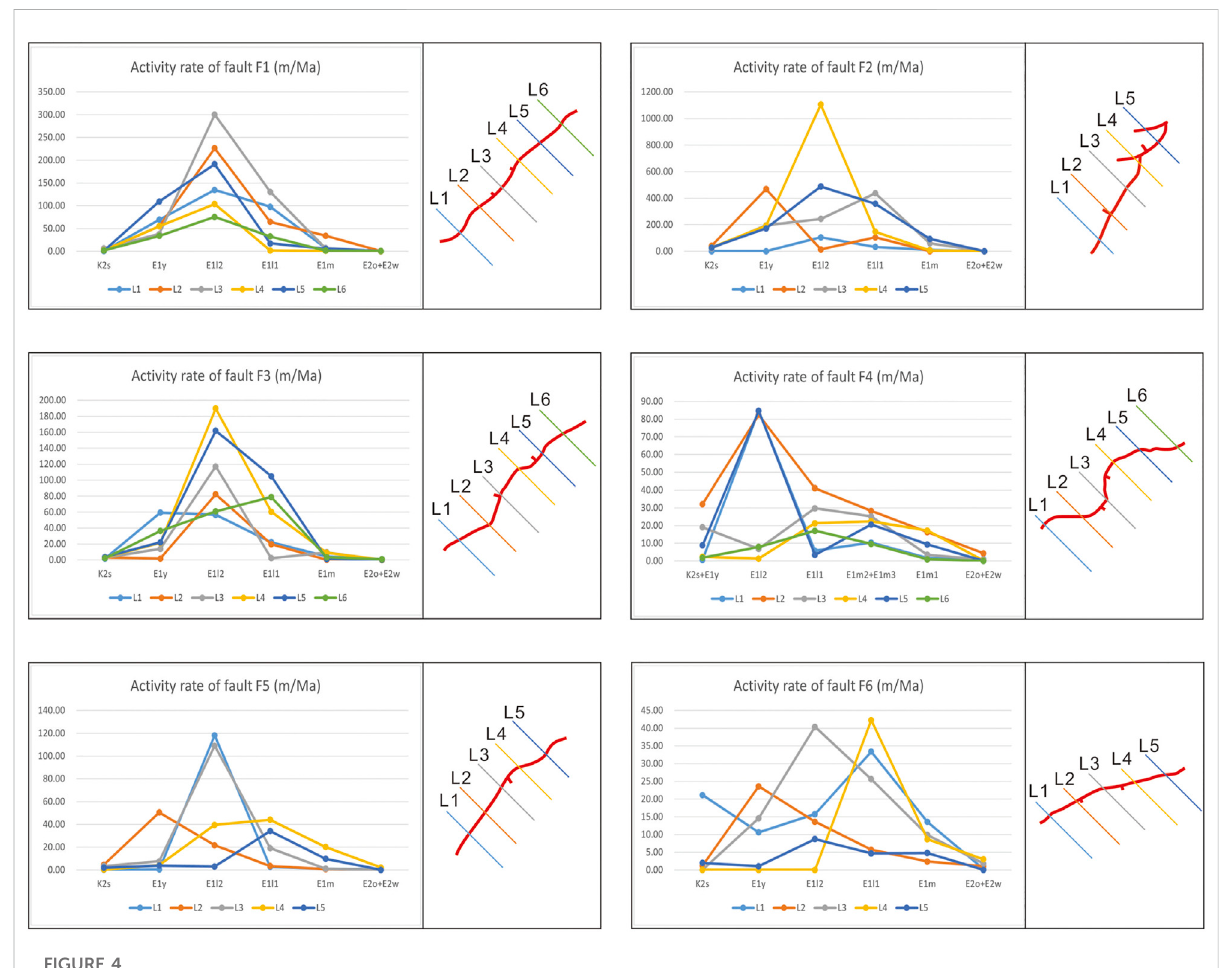
FIGURE 4 V of main boundary faults in the Lishui West Sag.